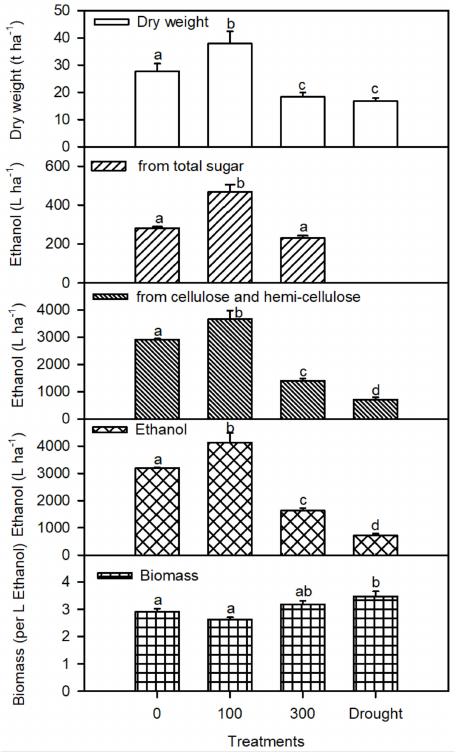
Figure 6. Plant dry biomass per hectare; ethanol yield per hectare from sugars; cellulose and hemicellulose; and the total ethanol yield of Phragmites karka under 0, 100, and 300 mM NaCl and drought. Values represent the mean ± S.E. of four replicates ( n = 4). Different lower-case letters indicate significant differences due to salt treatments, according to Bonferroni’s test ( p <